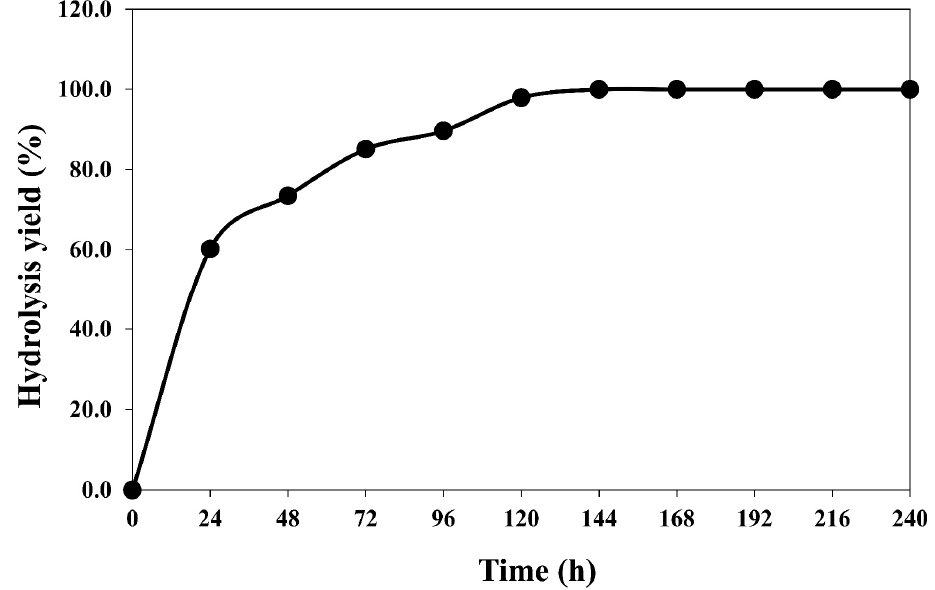
Figure 5. Time course of textile waste hydrolysis by commercial cellulase.